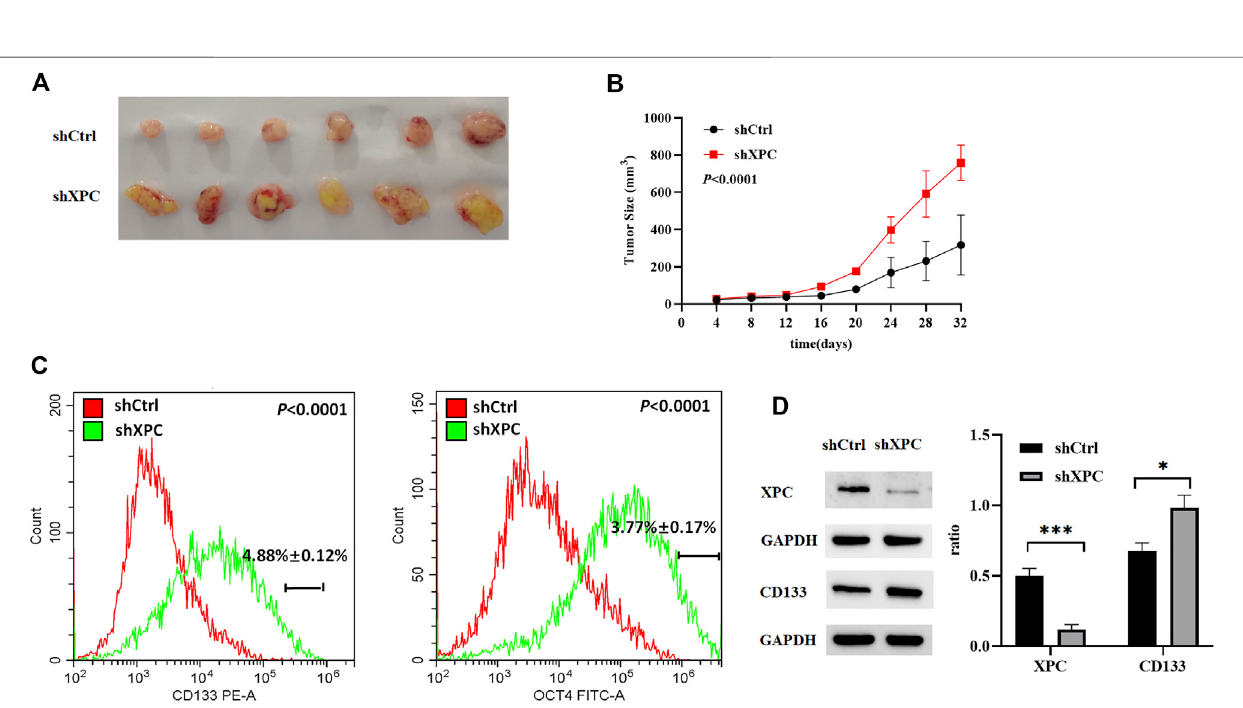
Frontiers in Pharmacology |